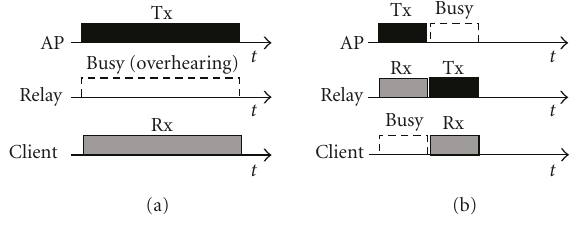
Figure 3: Radio Usage for Direct Transmission (a) and rDCF